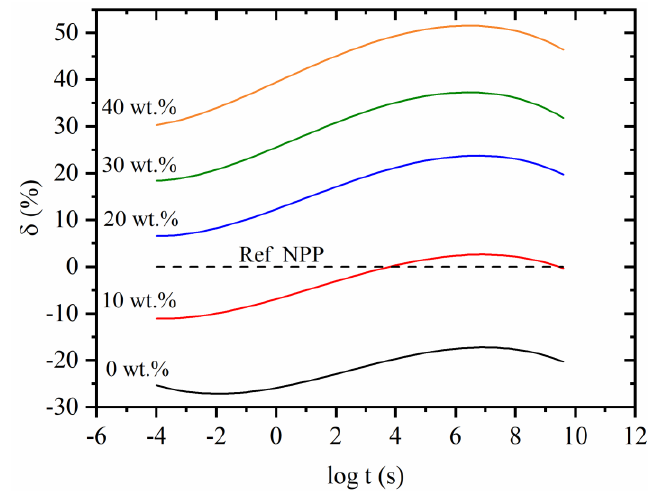
Figure 8. Creep compliance of composites with recycled (RPP) matrix relative to neat (NPP) matrix at 𝑇 𝑟𝑒𝑓 = 20 °C .